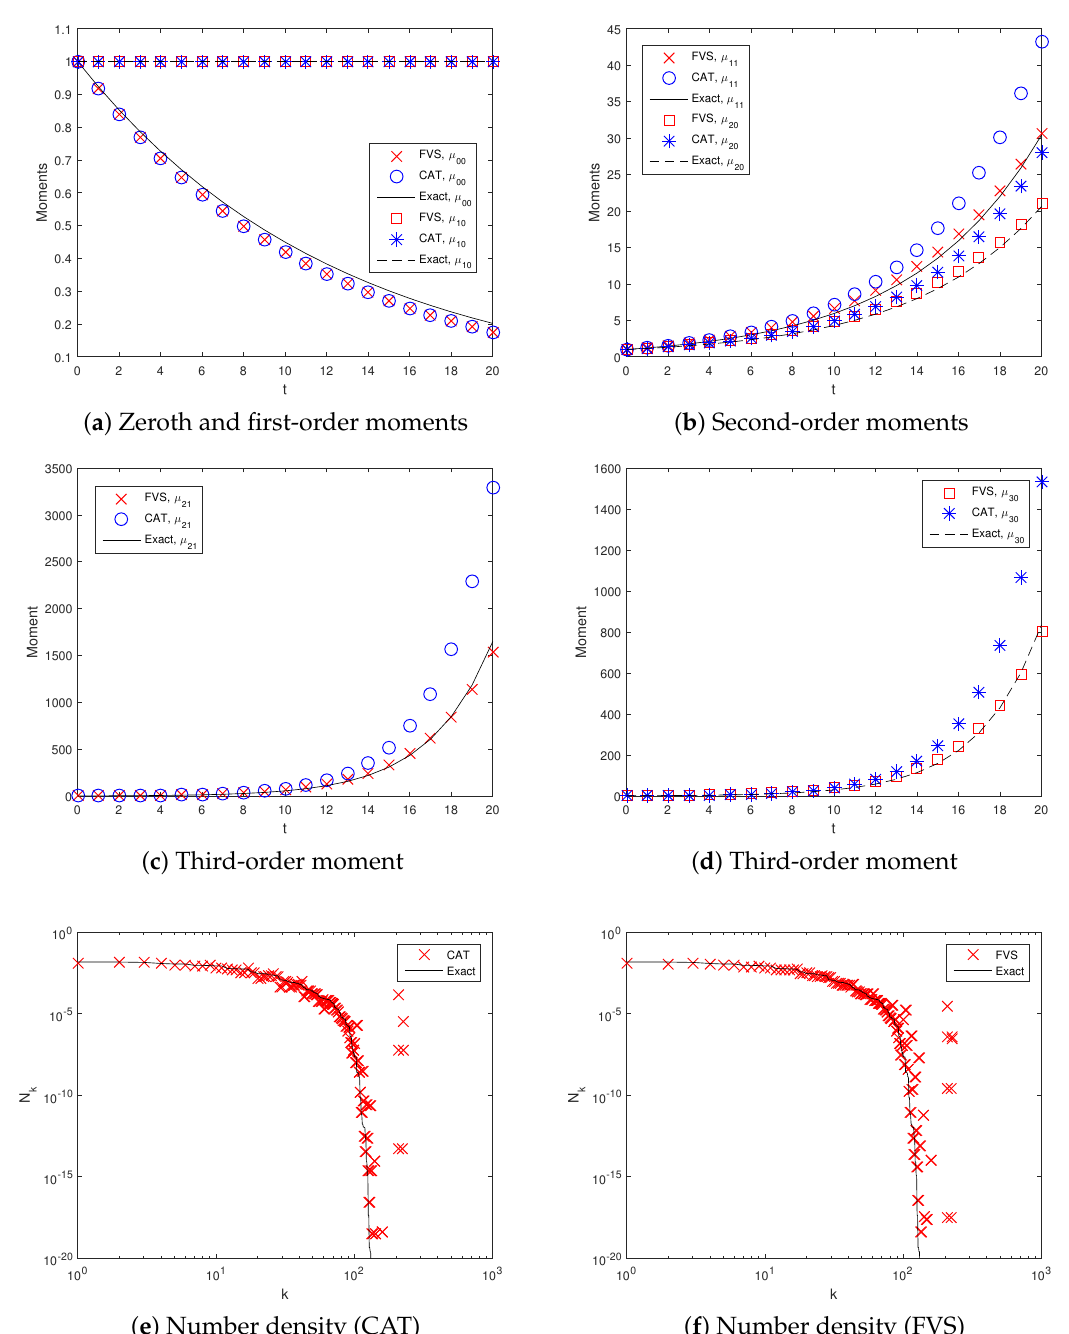
Figure 5. Different order moments and number density functions for sum